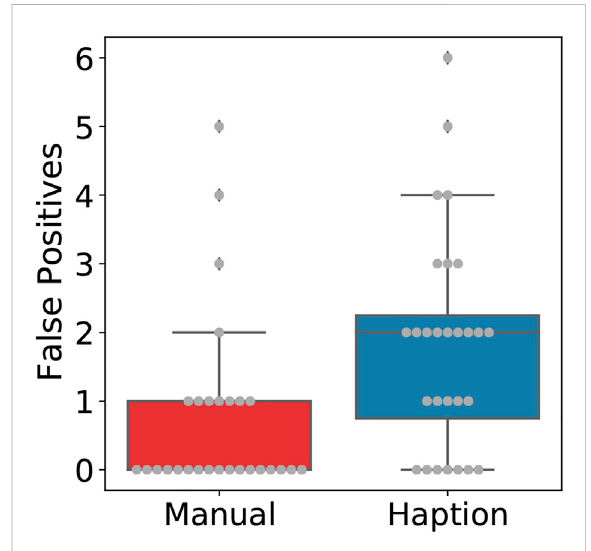
FIGURE 6 Boxplot with overlaid beeswarm plot comparing the number of false positives reported by test subjects per trial.